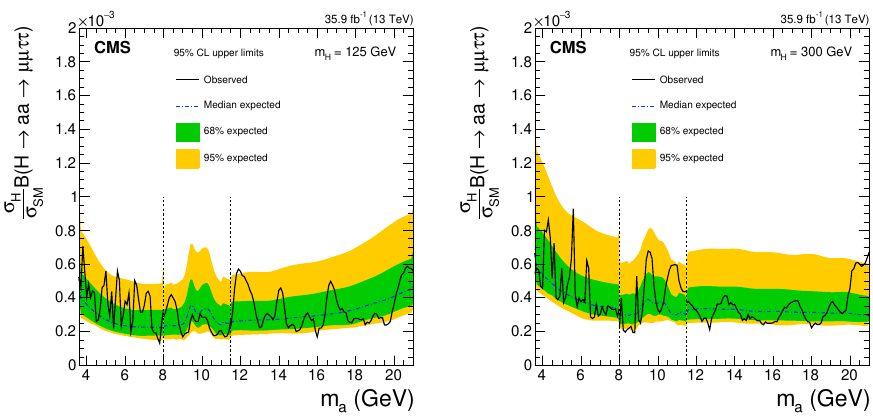
Figure 7 . Model-independent 95% CL upper limits on (cid:27) B (H ! aa ! (cid:22)(cid:22)(cid:28) (cid:28) ) =(cid:27) as a function H SM of pseudoscalar boson mass for a Higgs boson with m = 125 GeV (left), and 300 GeV (right). H The vertical dashed lines indicate the transition between the (cid:22)(cid:22) mass (cid:12)t ranges for a given mass hypothesis, occurring at m = 8 and 11.5 GeV. The inner (green) band and the outer (yellow) a band indicate the regions containing 68 and 95%, respectively, of the distribution of limits expected under the background-only